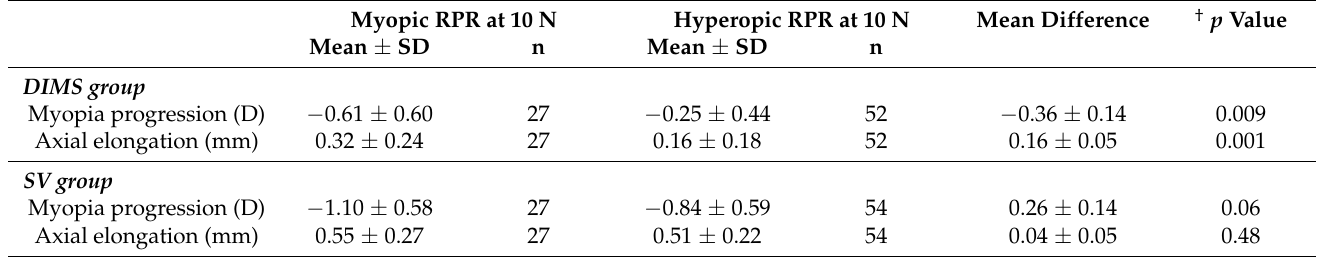
Table 2. The difference in myopia progression and axial elongation between children with myopic RPR and hyperopic RPR at 10 N in the DIMS and SV group, respectively.